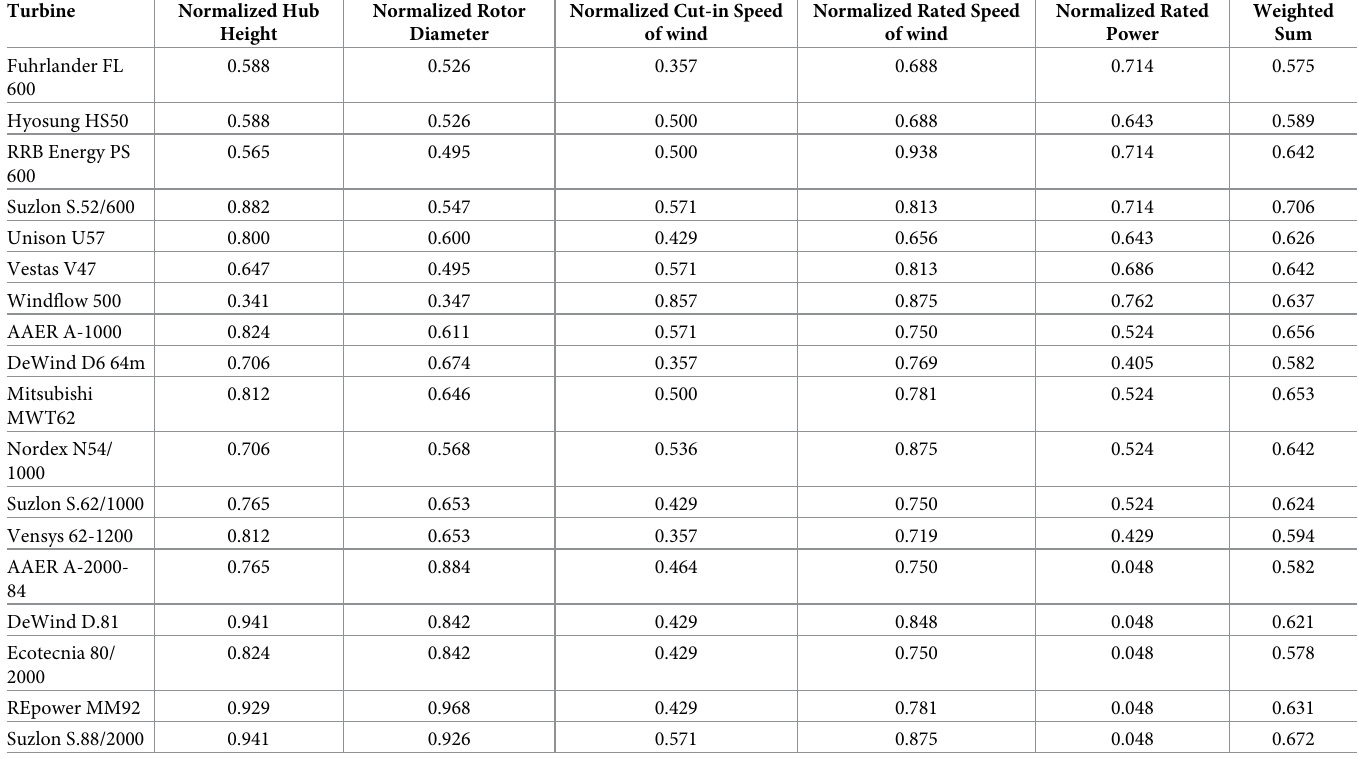
Table 7. The evaluation of all turbines with respect to all criteria, normalized matrix, [48]. Turbine Normalized Hub